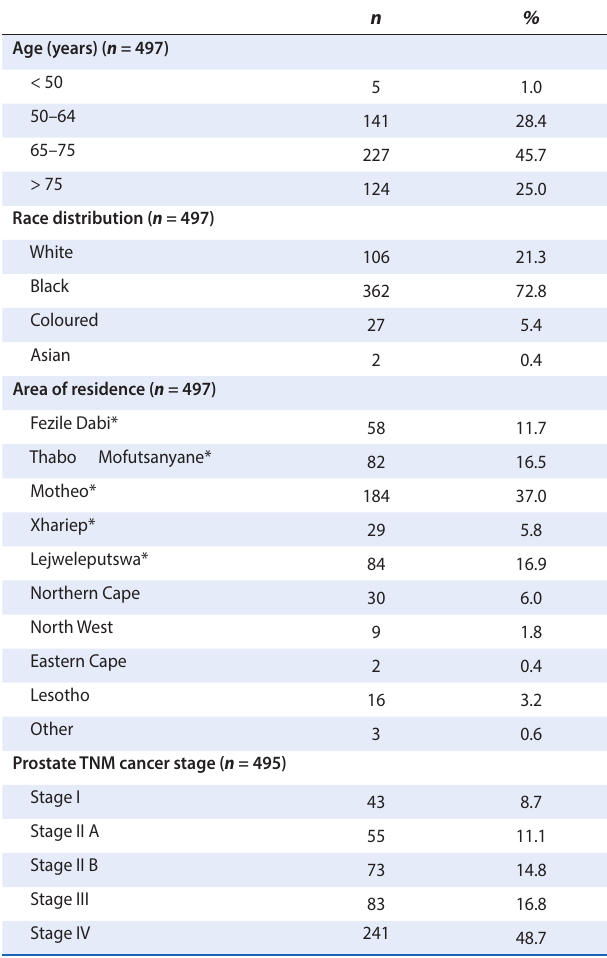
Table 2: Demographic data of patients with prostate cancer treated at Universitas Annex Department of Oncology during 2008 to 2010 n